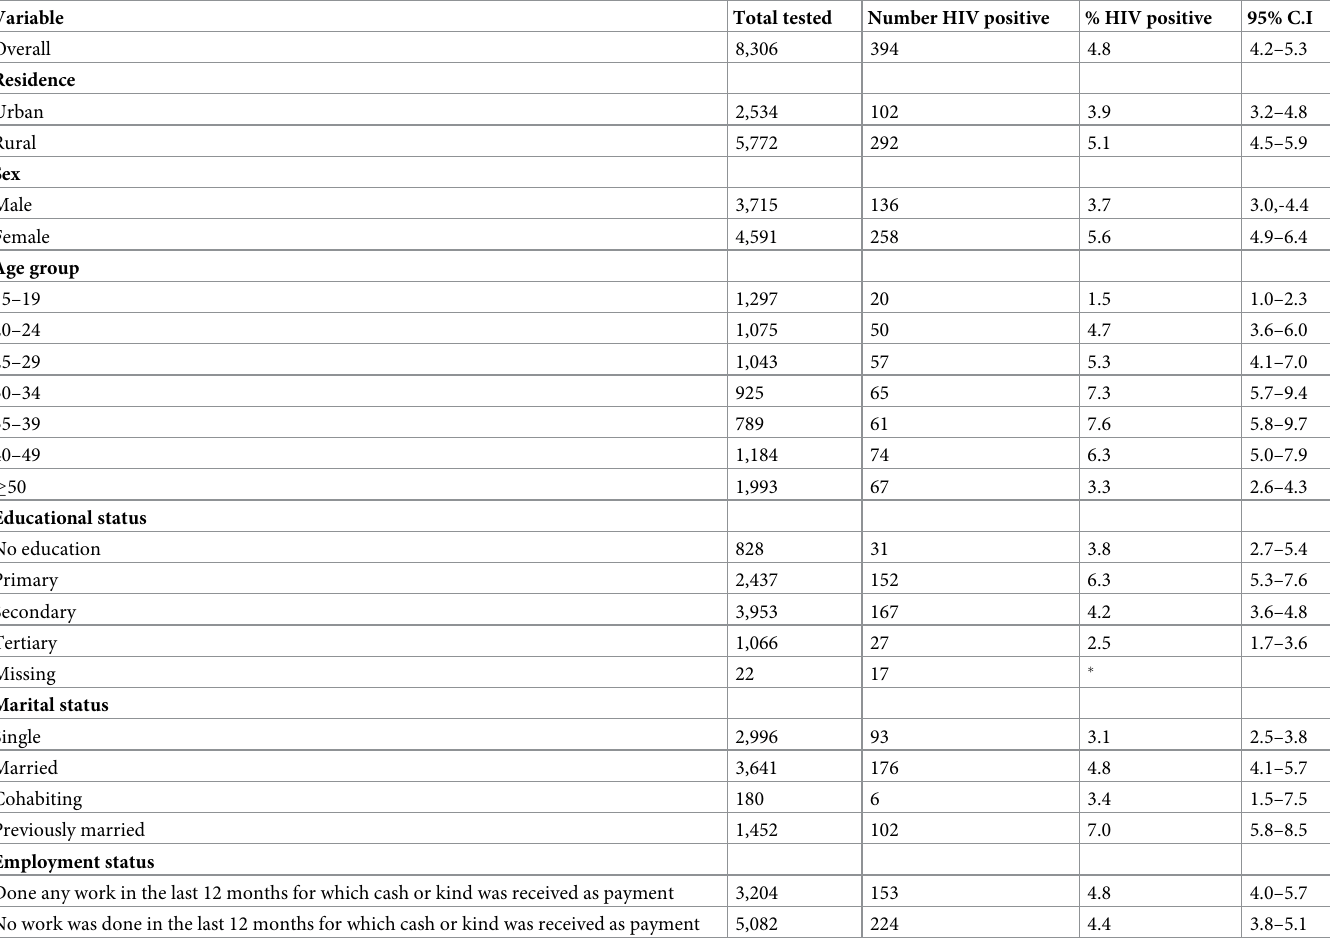
Table 3. HIV Prevalence among adults aged 15 years and older by selected socio-demographics AKAIS 2017.